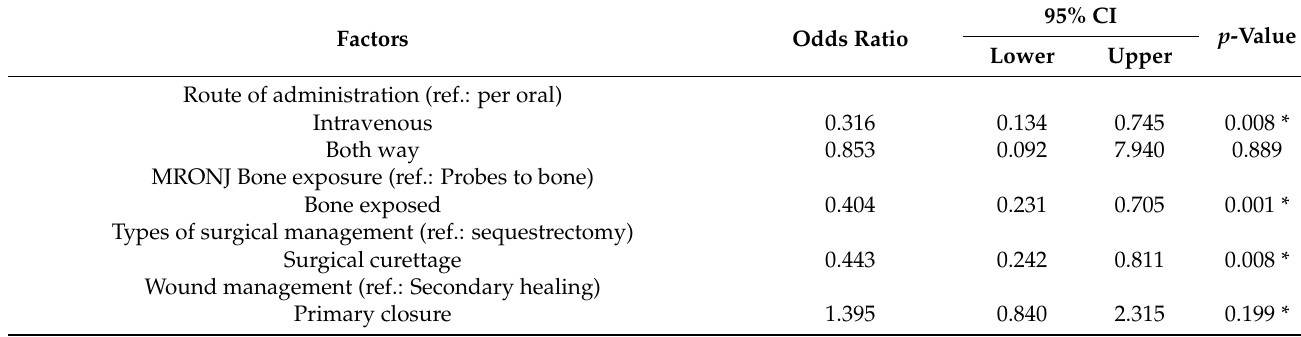
Table 4. Multivariate ordinal logistic regression